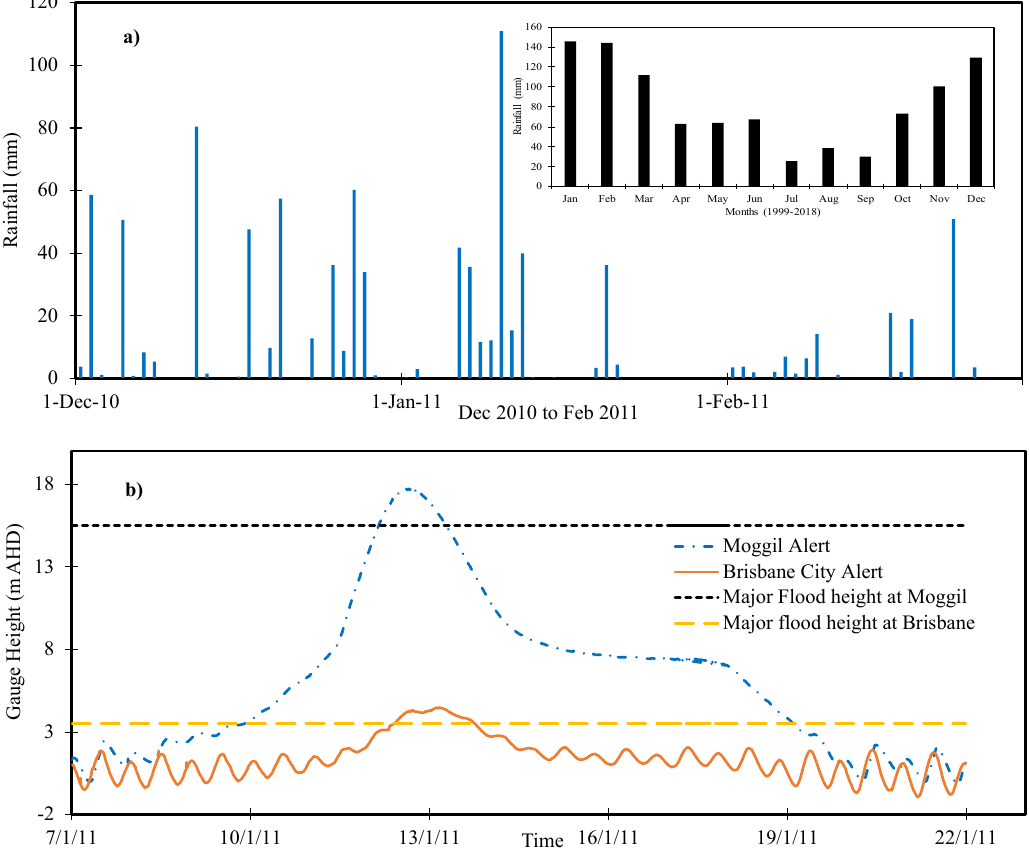
Figure 2. ( a ) Daily rainfall (2010–2011) and mean annual rainfall (1999–2018) at the Brisbane city office [40]; ( b ) Observed water level during the 2011 flood at Moggill and Brisbane city gauges, with reference to major floods.